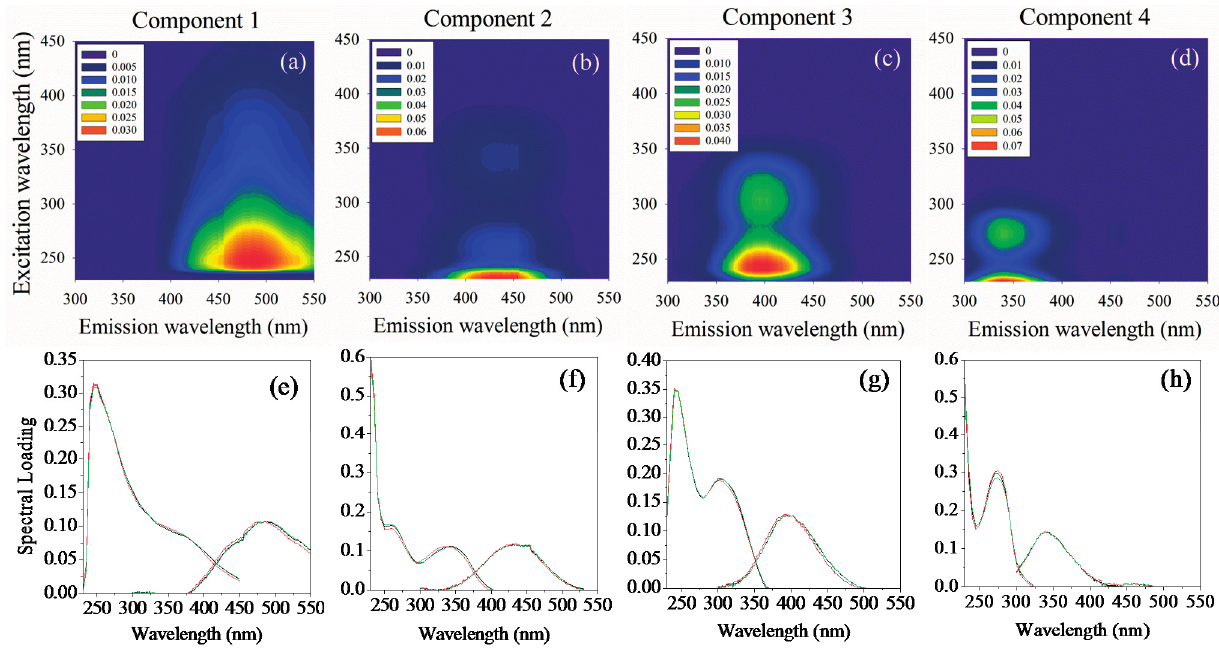
Figure 2. The contour plots show the E x/ E m locations of PARAFAC-derived components ( a – d ); The line plots show the spectral loadings of four components modeled with the halves of the dataset (green and red lines) and on the whole dataset (black lines) ( e – h